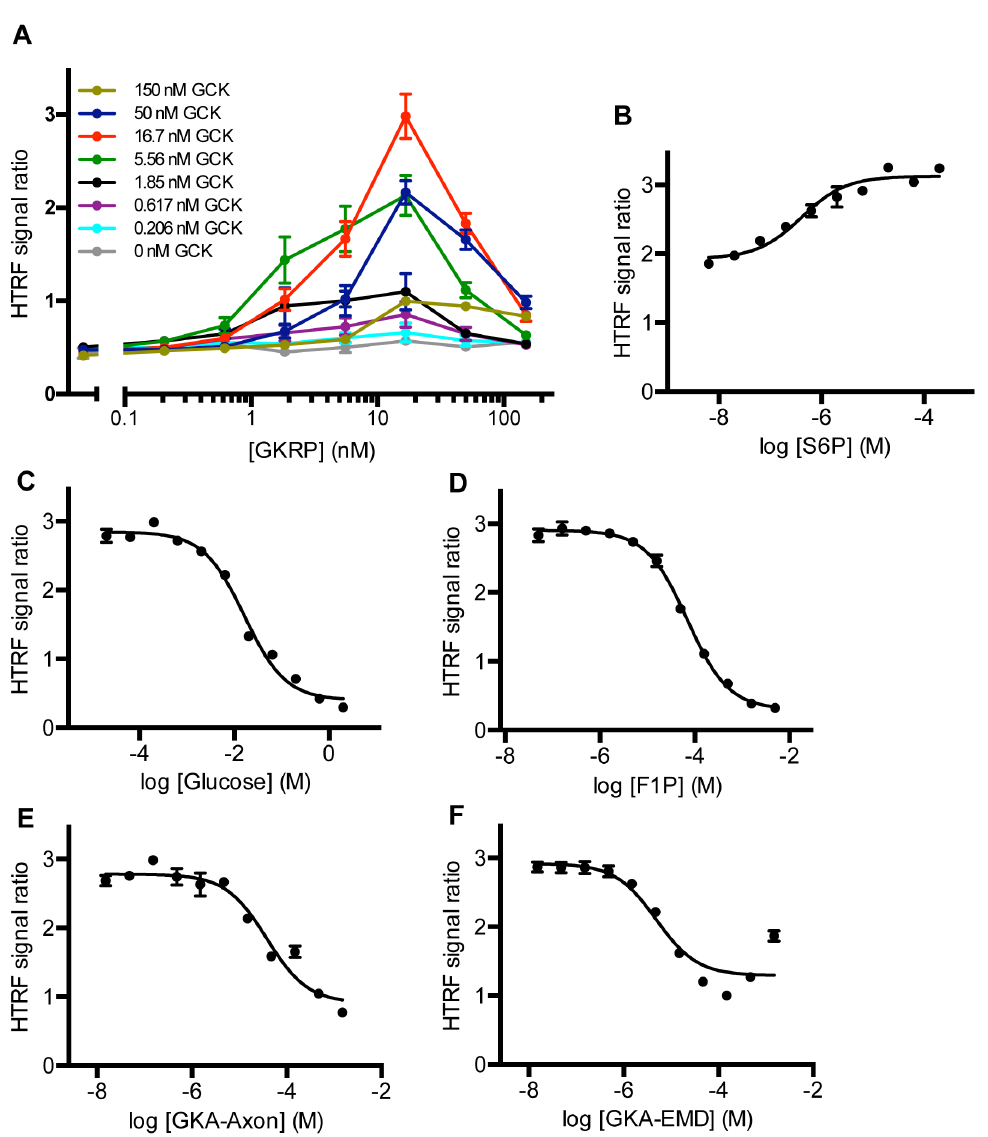
Figure 2. Optimization and validation of HTRF-based detection of the GCK-GKRP interaction. (A) Titration of GCK and GKRP. Results are presented as the ratio of the acceptor emission (665 nm) and donor emission (615 nm) for eight different GCK and GKRP concentrations measured at t=60 minutes. Each data point is mean 6 SEM for n=6. (B) Effect of S6P on HTRF detection of the GCK-GKRP interaction. The experiment was run in the presence of 5 nM GCK and 5 nM GKRP. Values shown are mean 6 SEM (n=8 for each [S6P]). (C–F) Effect of known inhibitors glucose (C), F1P (D), and two GKAs (E–F) on HTRF detection of the GCK-GKRP interaction in the presence of 5 nM GCK, 5 nM GKRP, and 2 m M S6P. Values shown are mean 6 SEM (n=8 for each